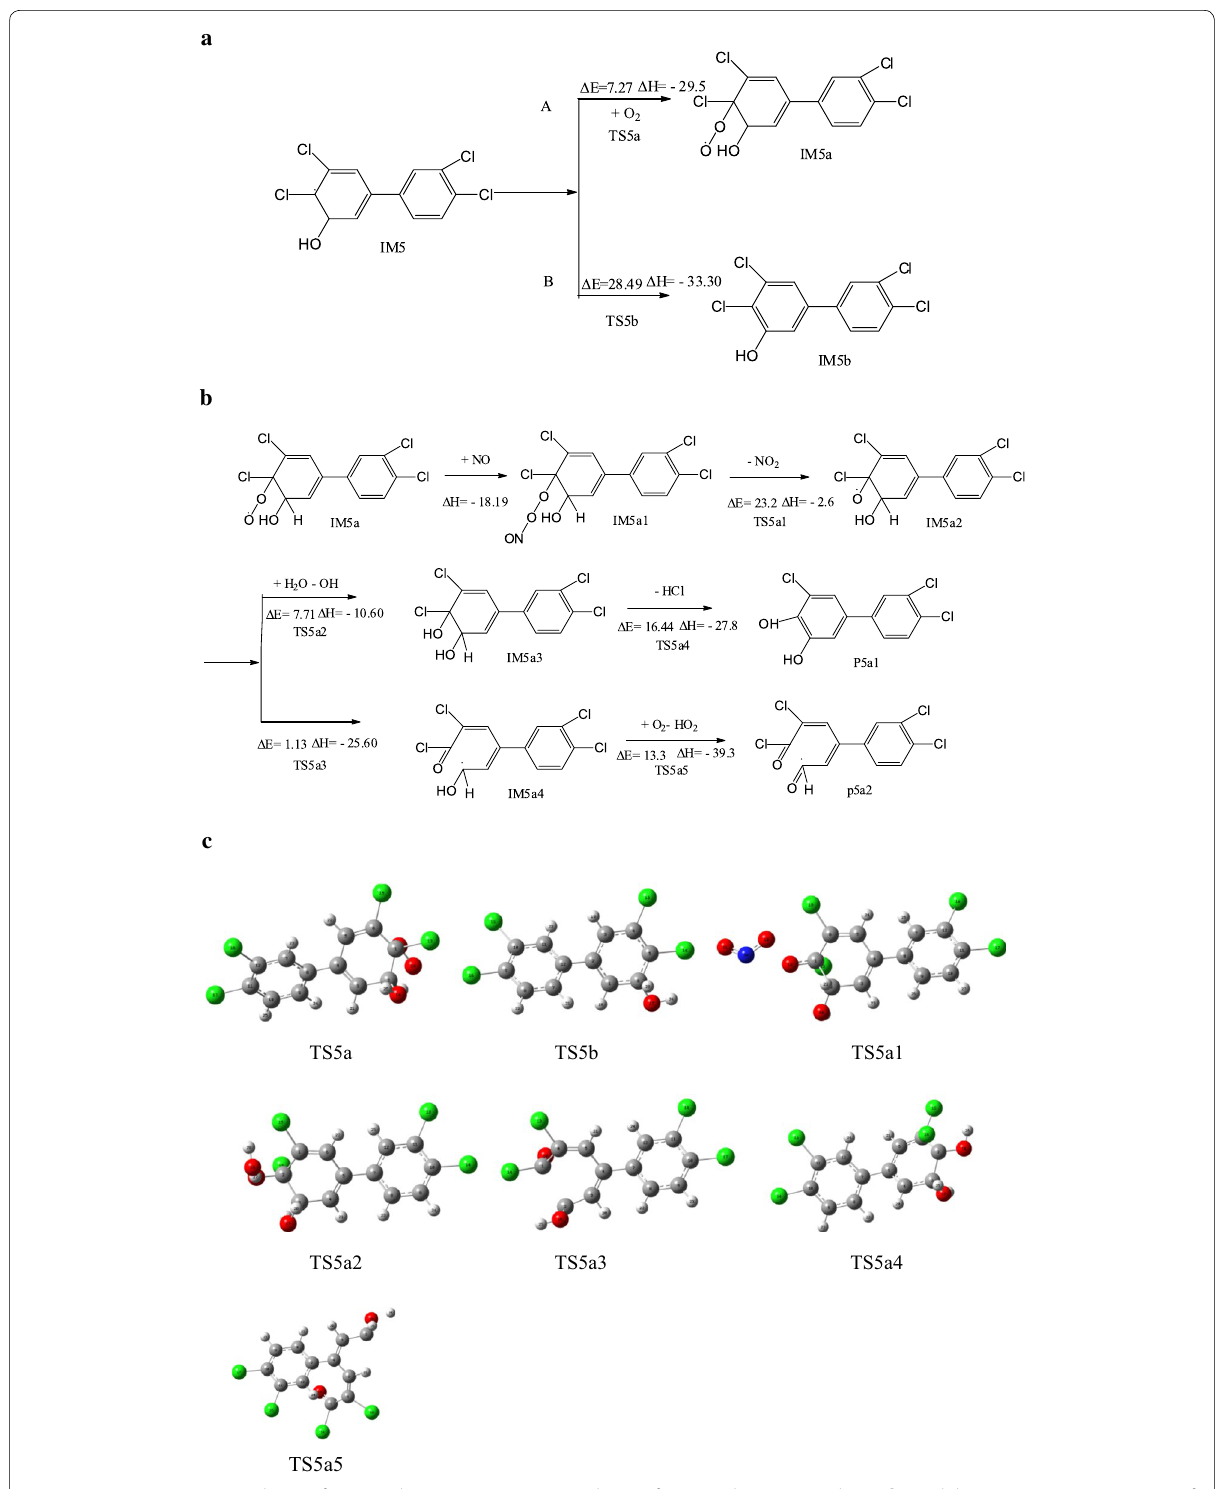
Fig. 4 Two stage reaction pathway of intermediate IM5 ( a ), reaction pathway of intermediate IM5a with NO ( b ), and the transition state structure of IM5a with O 2 /NO ( c ). [∆E (kcal/mol): energy barrier, ∆H (kcal/mol): reaction